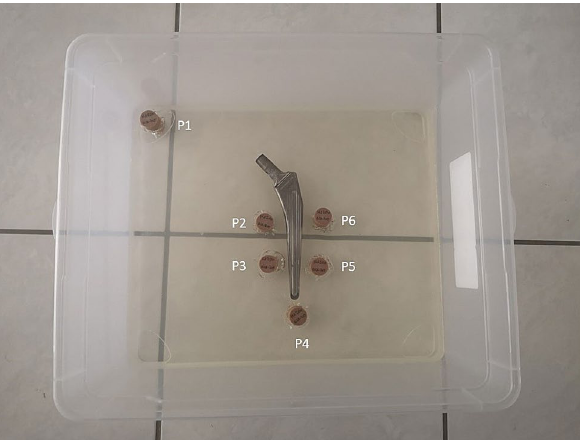
Figure 1. Image illustrates a phantom with implanted metal alloys. The construction was made for stainless steel, chrome-cobalt and titanium. Six calcium hydroxyapatite pellets (P1–P6) were implanted. Five pellets are surrounding the femoral stem and one pellet was placed far away from the implant and was used as the reference